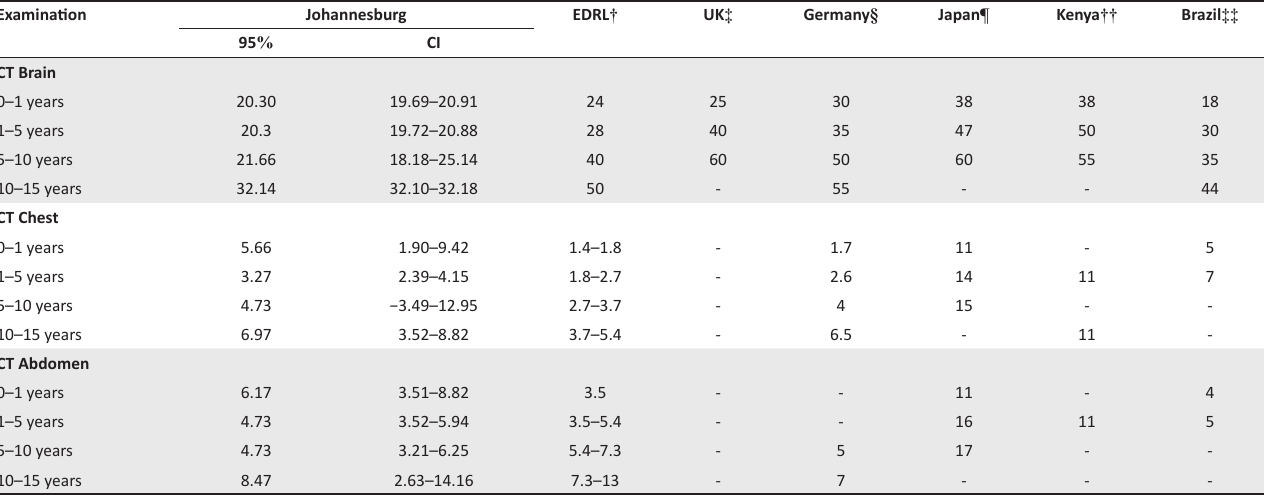
FIGURE 1: Comparative 75th percentile for dose length product in mGy * cm for each time category for computed tomography brain at Charlotte Maxeke Johannesburg Academic Hospital and Rahima Moosa Mother and Child Hospital ( n = 687). TABLE 7: Computed Tomography Dose Index 75th percentiles (mGy) of Johannesburg hospitals compared to international diagnostic reference volume